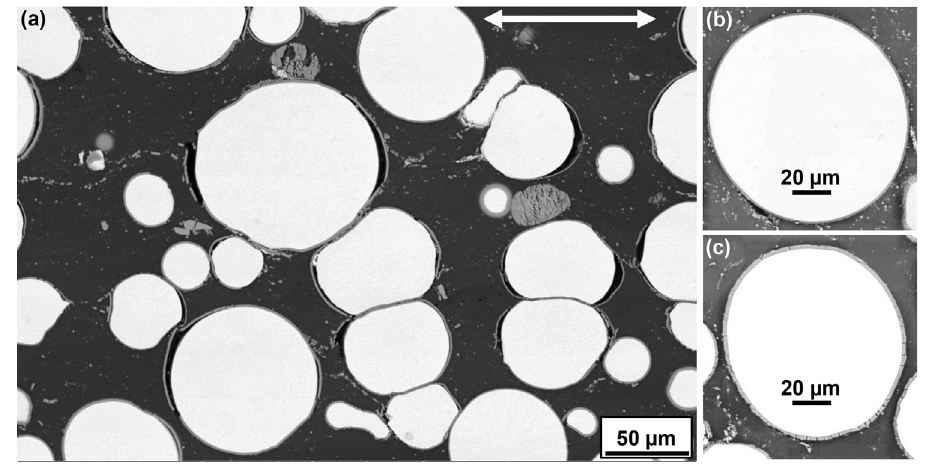
Fig. 4. SEM micrographs taken on (a) EMP-717 (cross-section), (b) SF-202, (c) EMP-819 plates.